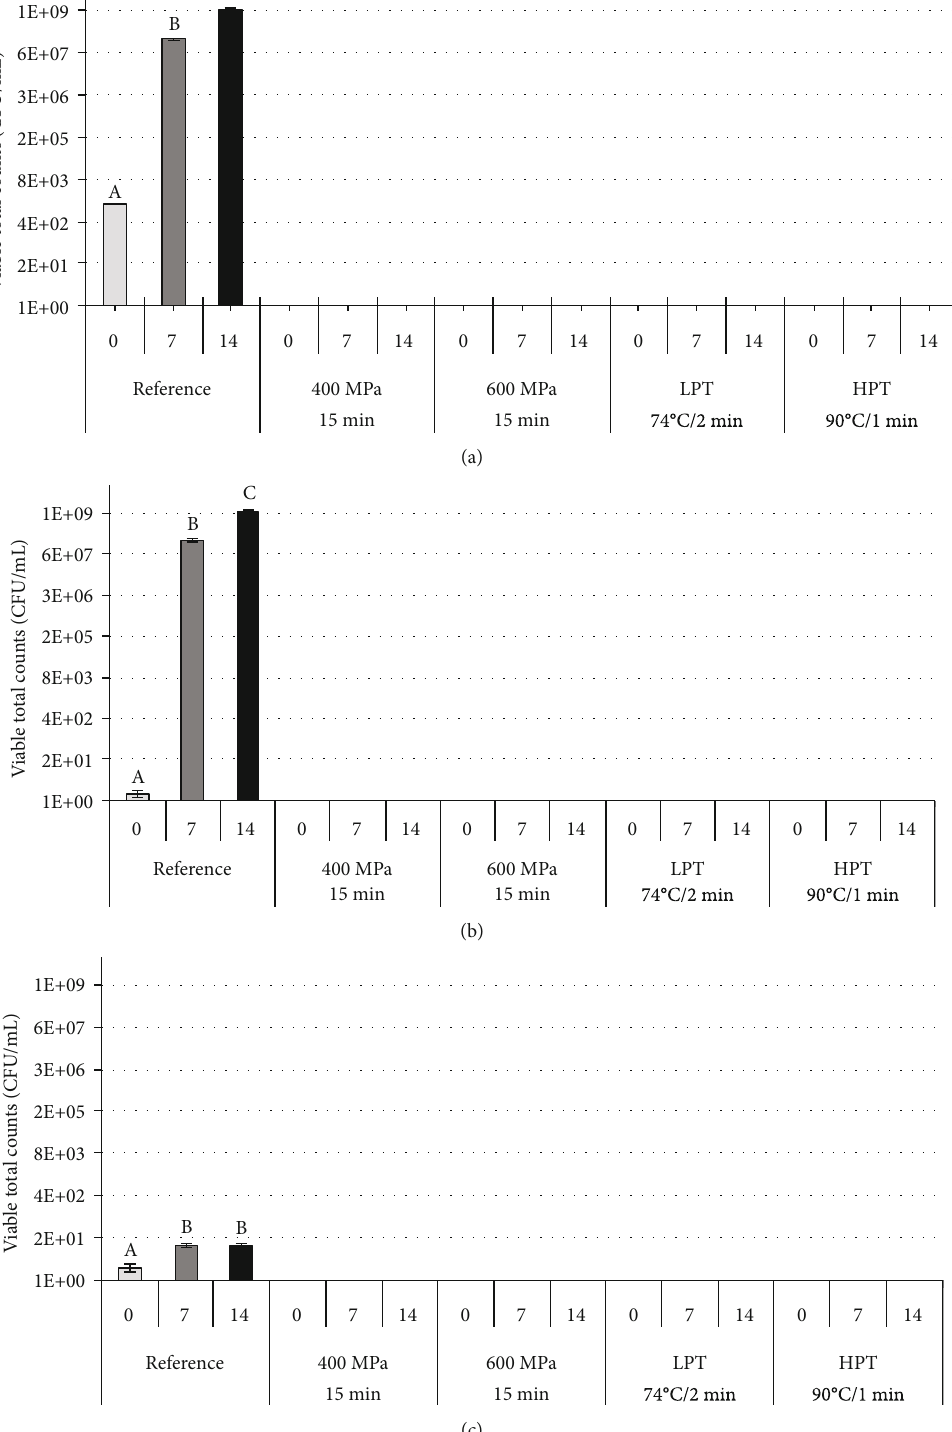
Figure 2: Average total bacterial count (a), total yeast count (b), and total mould count (c) as analysed in the untreated, HHP-treated, and pasteurized (LPT and HPT) tomato juice after storage for 0, 7, and 14 days. The mean values denoted with the same letter are not signi fi cantly di ff erent, p < 0 : 05 . ∗ Below the detection limit of <